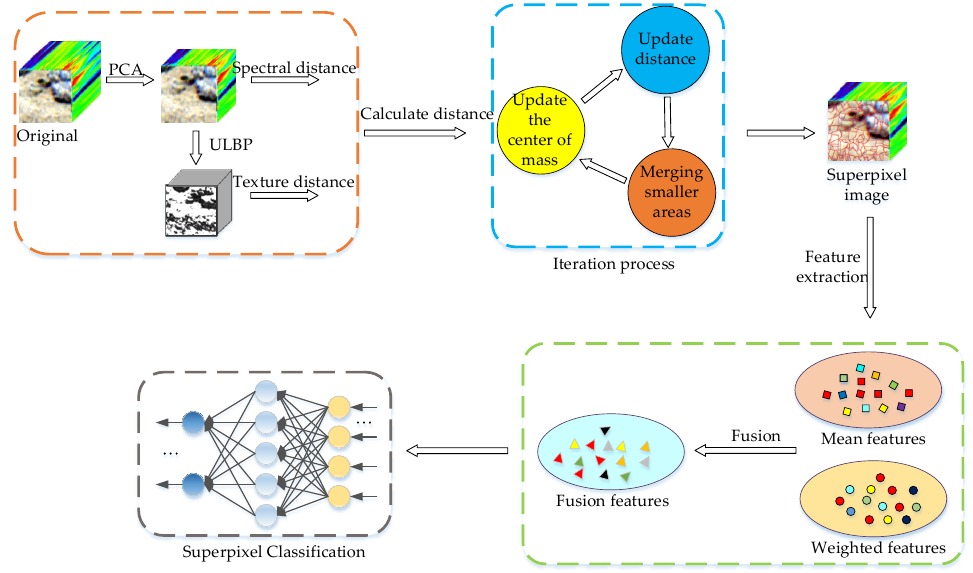
Figure 1. Schematic diagram of LMSLIC-FCM algorithm structure.